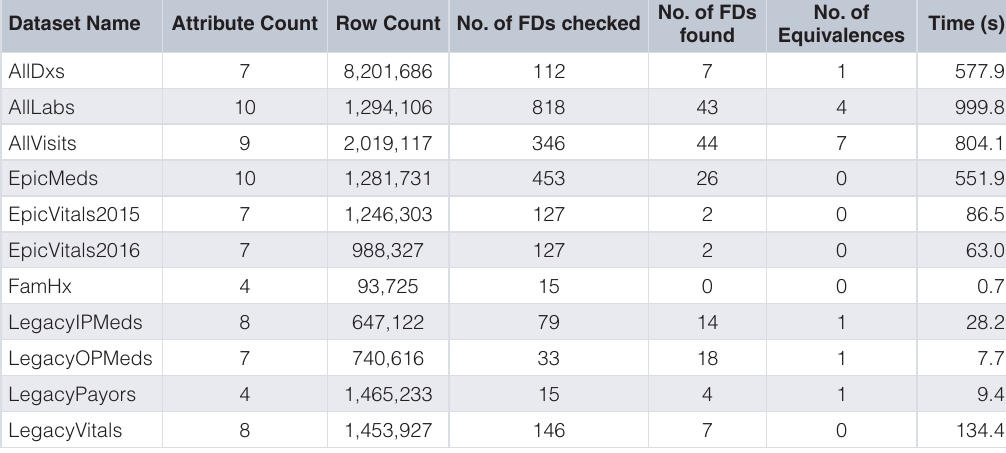
Table 2. Experimental results of FDTool on 11 CARES datasets, which terminate in less than 4 hours (preset limit). Dataset